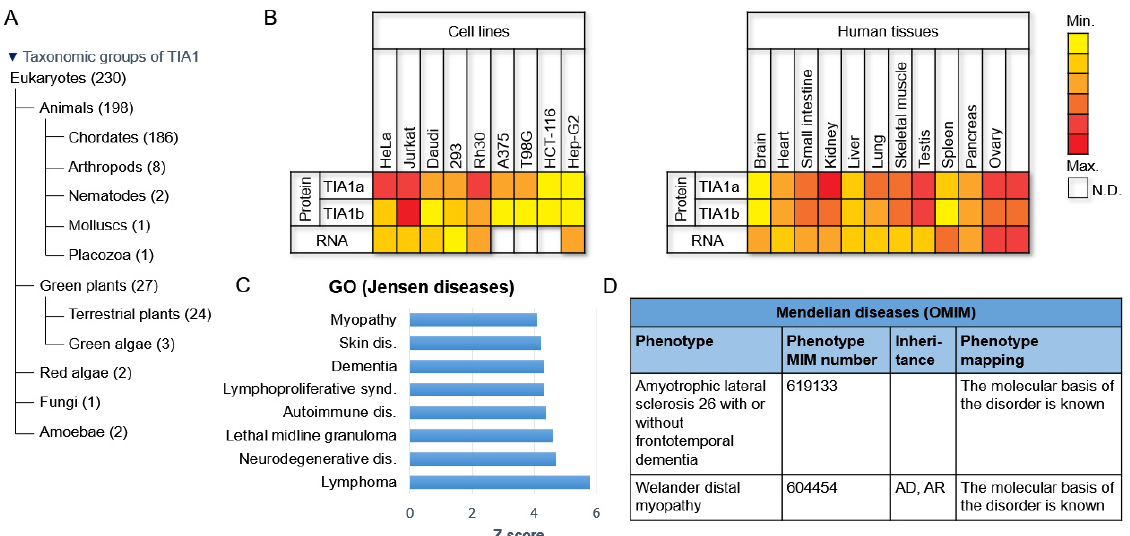
Figure 4. Phylogenetic trees, cellular- and tissular-expression profiling, and Jensen and Mendelian diseases associated with TIA1. ( A ) Taxonomic groups of TIA1 and TIAR orthologs according to the NCBI (National Center for Biotechnology Information) database. ( B ) Expression patterns of TIA1 in human cell lines and in human and mouse tissues. HeLa (uterine carcinoma), Jurkat (T lymphoma), Daudi (B lymphoma), HEK293 (human embryonic kidney), Rh30 (bone marrow rhabdomyosarcoma), A375 (melanoma), T98G (glioblastoma), HCT-116 (colon carcinoma), Hep-G2 (liver carcinoma). ( C ) Gene Ontology (GO) of human diseases related to TIA expression, according to Jensen’s classification. ( D ) Catalog of genetic disorders associated with TIA1 expression based on the Online Mendelian Inheritance in Man (OMIM)